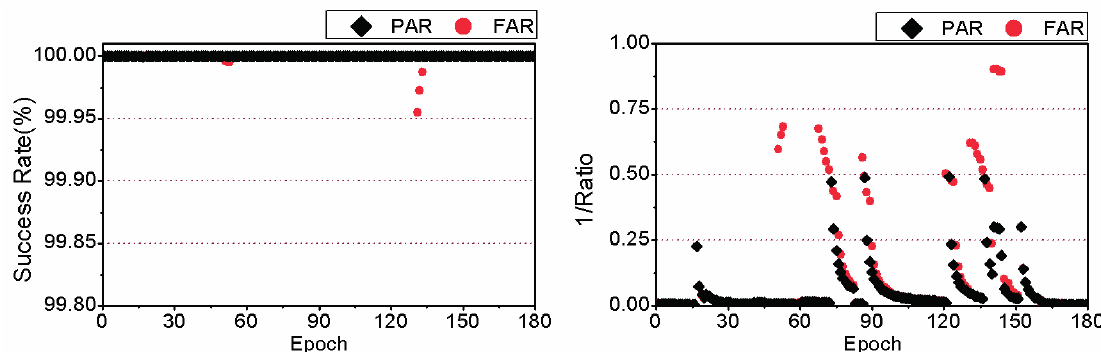
Figure 9. Success rate ( Left ) and reciprocal of ratio test value ( Right ) of static PPP with PAR and FAR for the observations of the 4th session of the MOBS station on 25 January 2012.